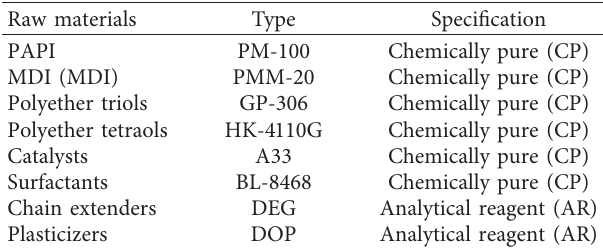
Table 1: Type of raw materials.